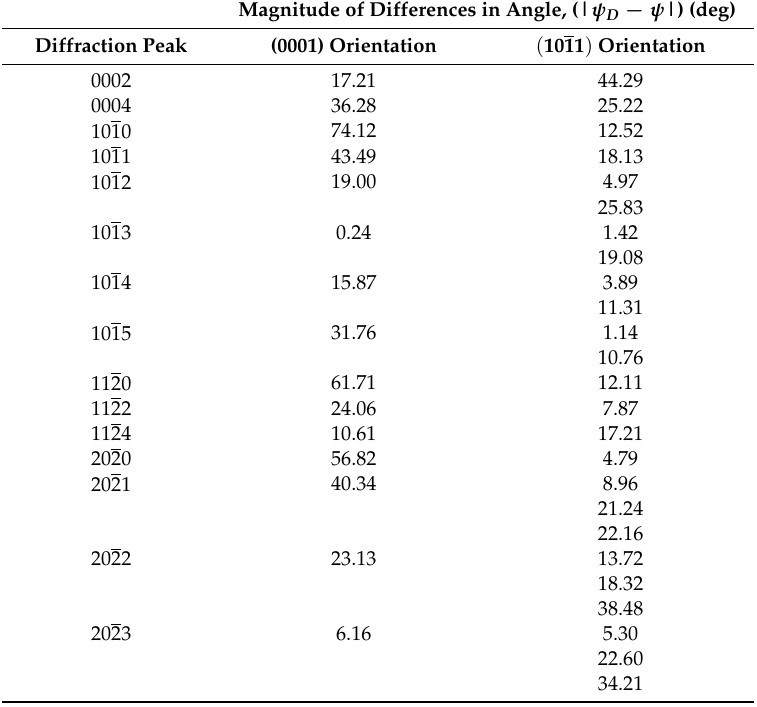
Table A1. Magnitudes of the differences in angles (| ψ D − ψ |) between the diffraction peak ( ψ D ) in cases of (0001) or ( 1011 ) orientation and trajectory of out-of-plane grazing-incidence XRD ( ψ